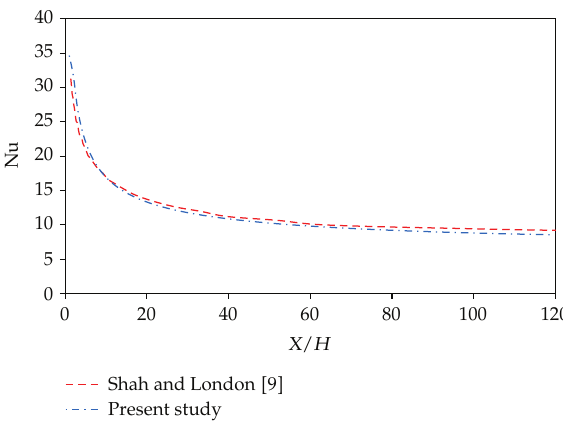
Figure 3: Comparison of present numerical results with those obtained by Shah and London (cid:8) 9 (cid:9) .